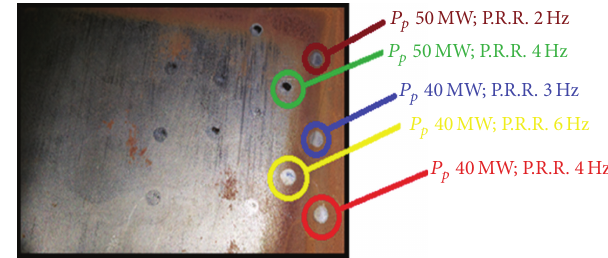
Figure 11: Photographic image of